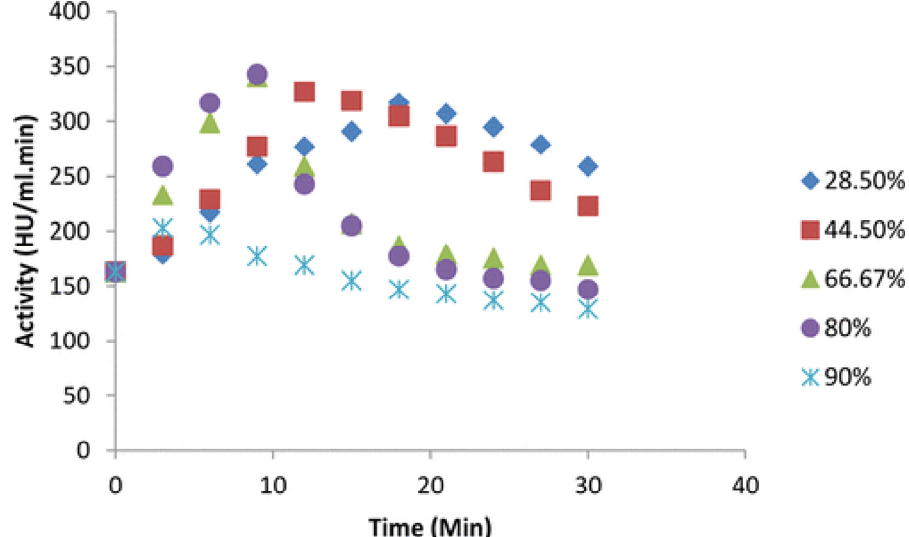
Figure 8. The change of enzyme activity with different duty cycles of ultrasound irradiation in 30 min (intensity: 12.22 W/cm 2 , enzyme concentration: 3.0 g/mL). Reprinted with permission from Jadhav et al., American Chemical Society [111].